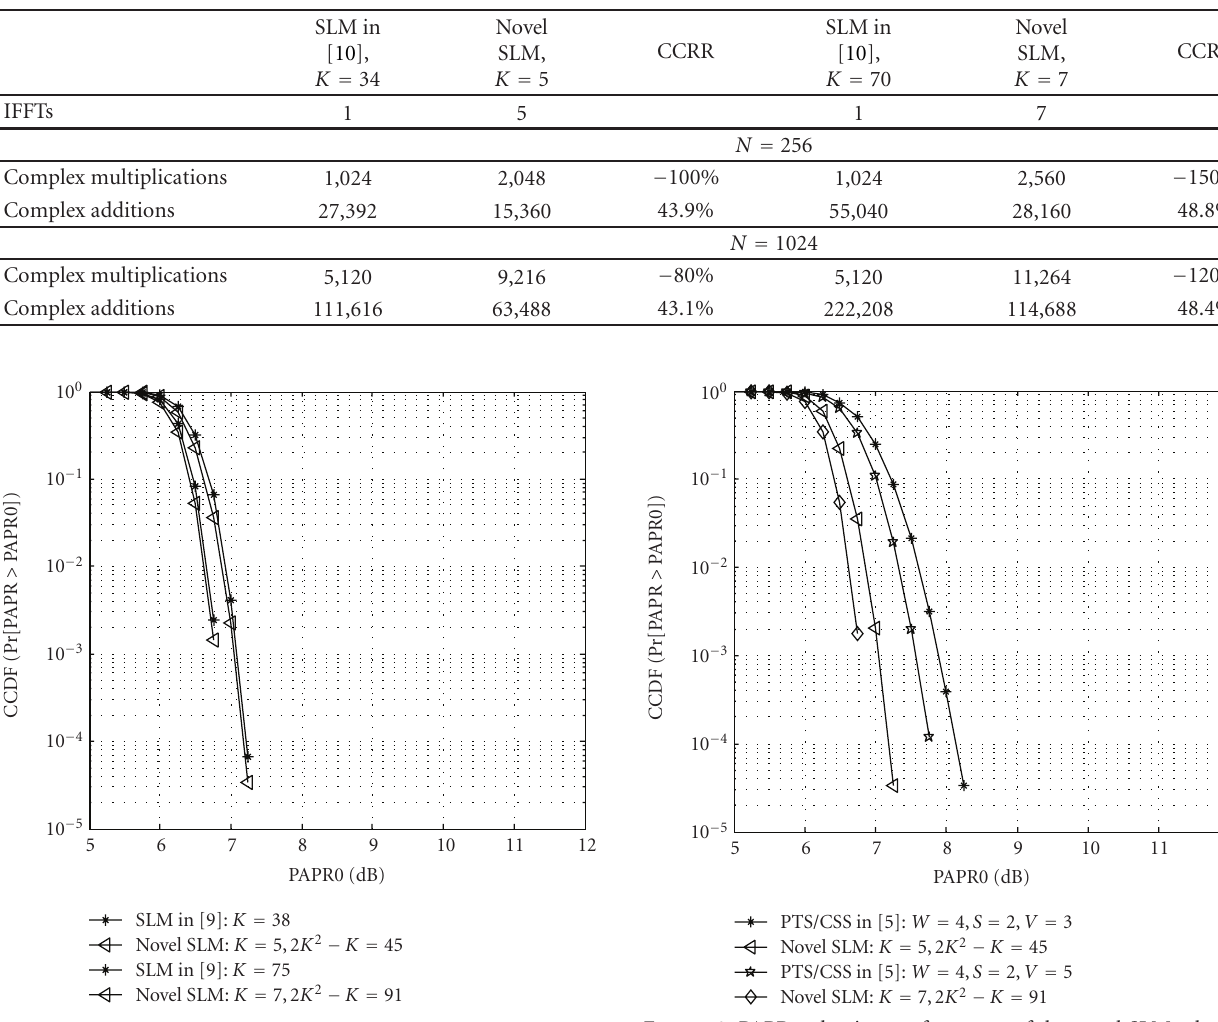
Figure 7: PAPR reduction performance of the novel SLM scheme and the SLM scheme in [9].